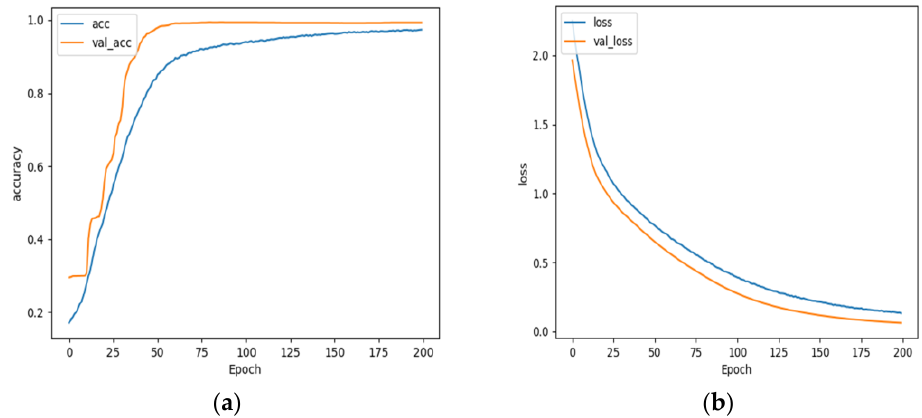
Figure 18. ( a ) Accuracy rate; ( b ) Loss rate of the two-dimensional CNN for the packet traffic model.